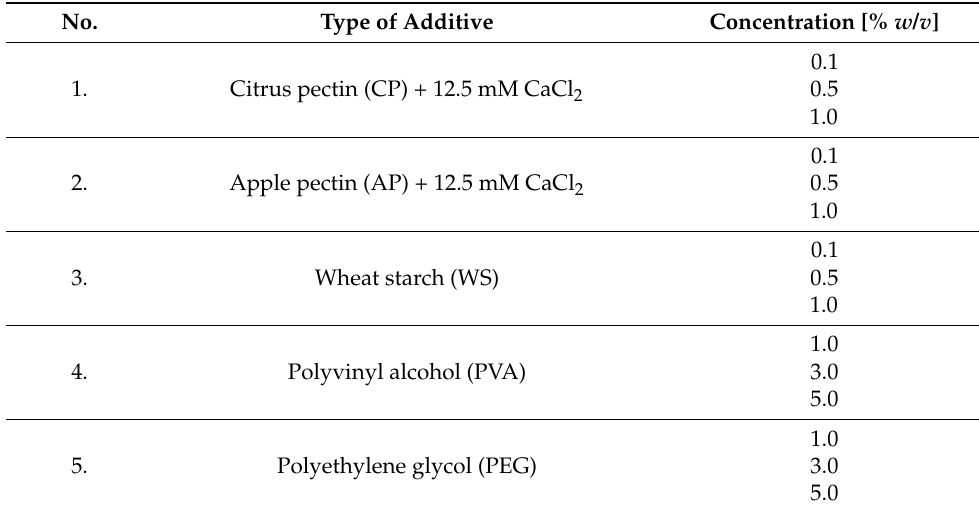
Table 2. Summary of the conducted modifications of SH